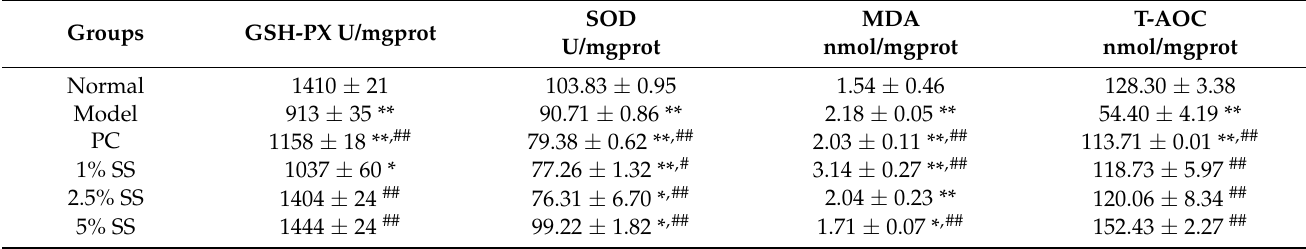
Table 4. Effects of oral SS administration on the antioxidant activities in the liver of T2D